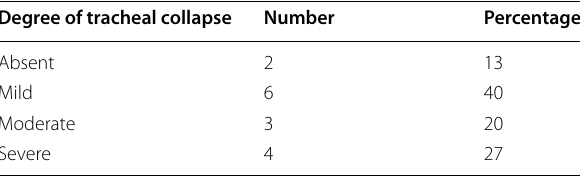
Table 1 Main symptoms reported in the patients Table 2 Patients with different degrees of trachea collapse